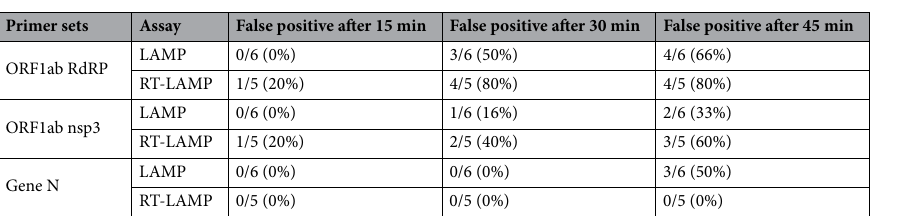
Table 1. Summary of false positives detected in no template control in biological repeats (n=5-6).